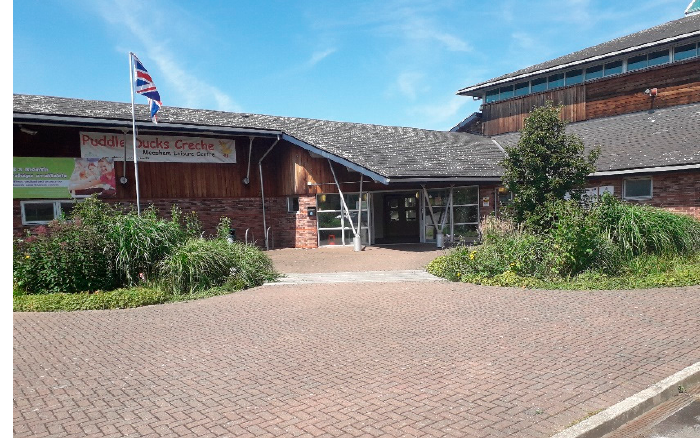
Figure A1. Front view of the Leisure Centre.